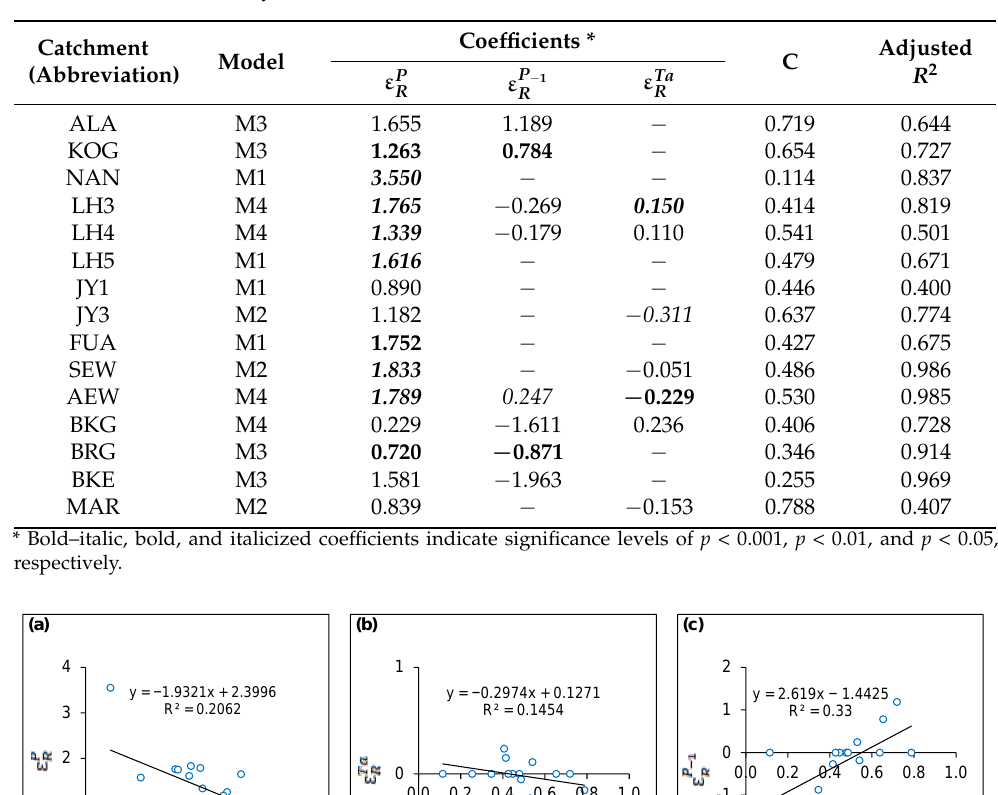
, ( b ) ε Ta , and ( c ) ε P − 1 R R